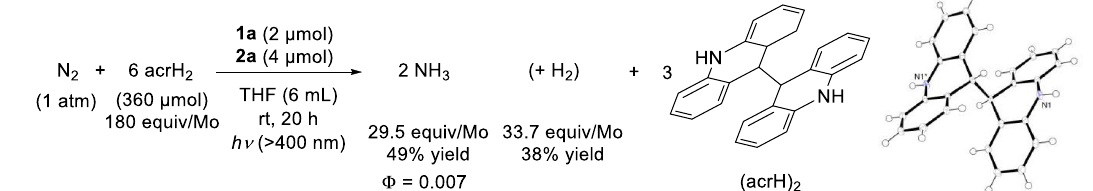
to form the reduced iridium catalyst ( 3 ) and acrH 2 • + . c Light on/off experiment. d Kinetic isotope effect (KIE) on the visible light driven ammonia